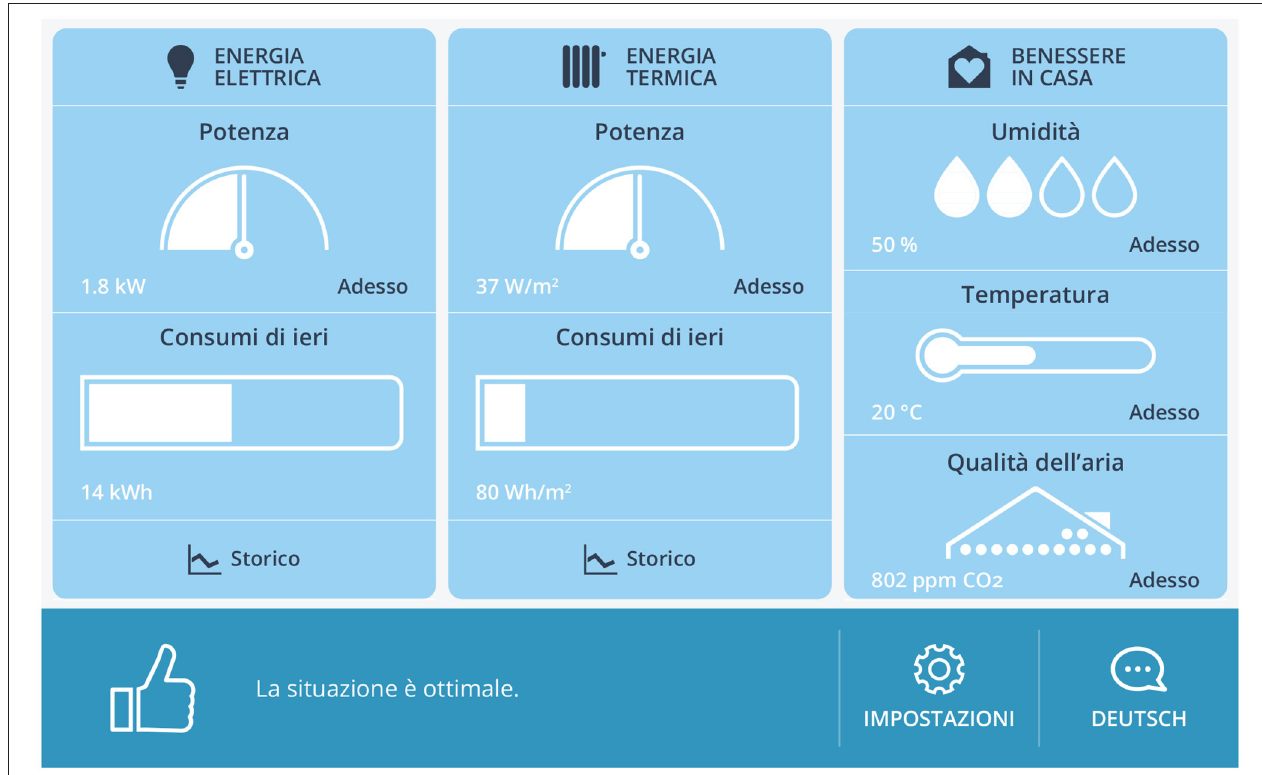
FIGURE 1 | Control group home